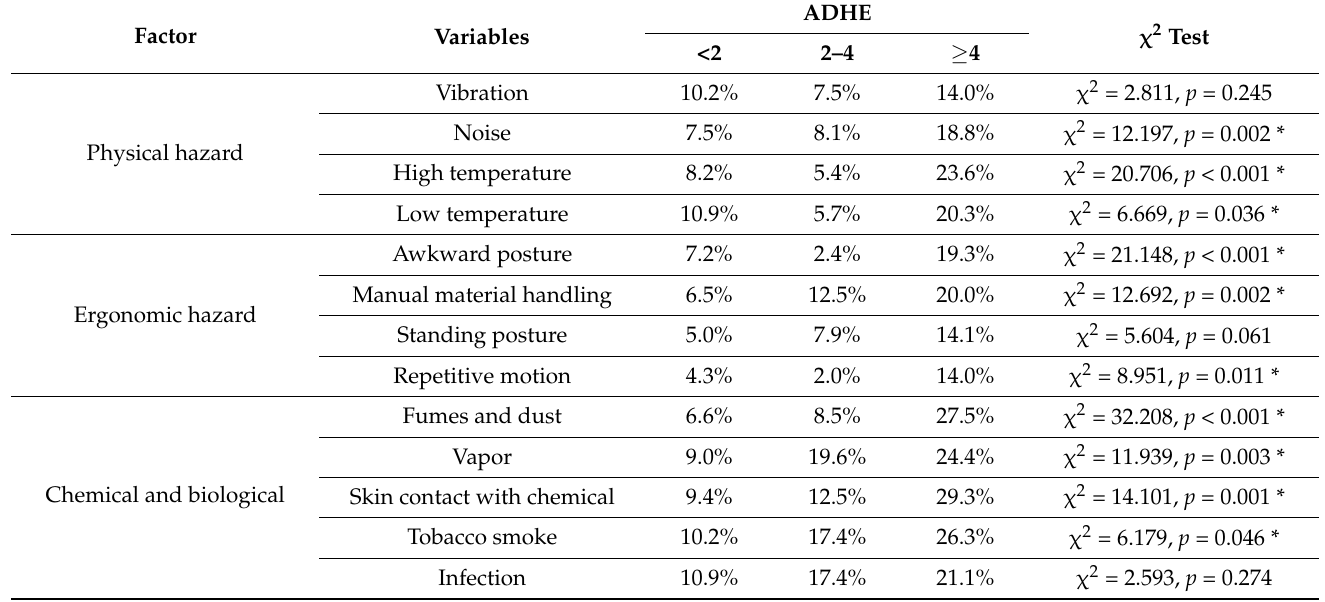
Table 9. Distribution of subjective lower limb pain by the degree of hazard exposure.